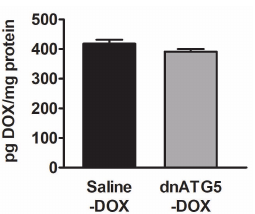
Figure 6. The relative concentration of DOX in the soleus muscle. Values are represented as means ±